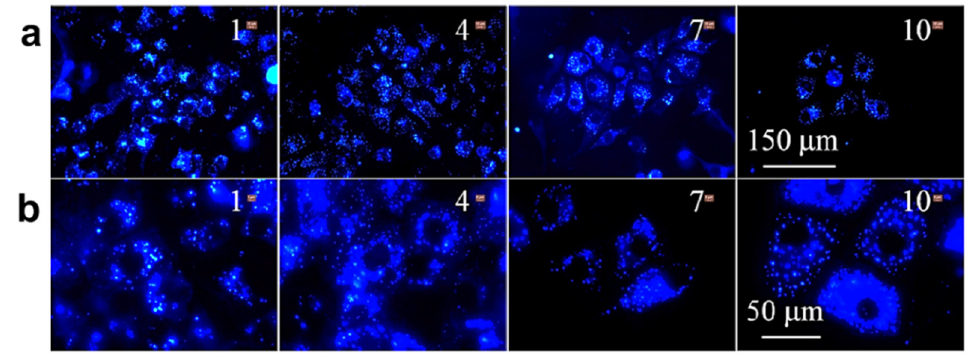
Figure 12. The fluorescence images of A549 cells upon incubation with a P6 probe (100 μ g/mL) were captured at magnification ( a ) ×40 and ( b ) ×100. Reprinted from reference [84] with the permission of the American Chemical Society.